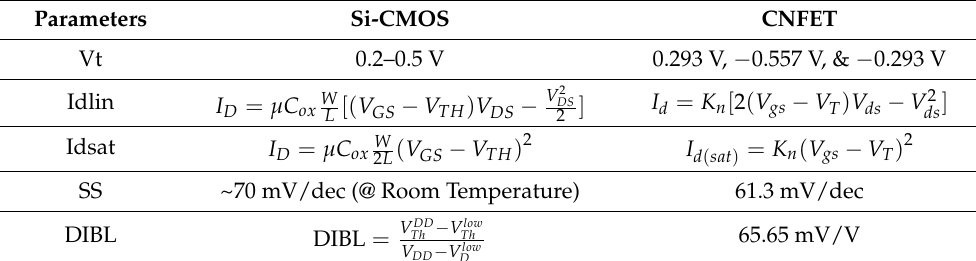
Table 1. Parameters of Si-CMOS and